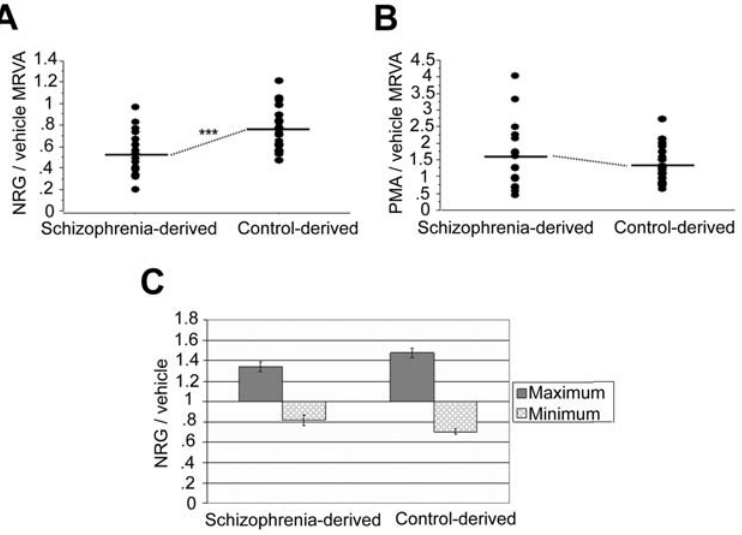
Figure 8. Neuregulin-1-induced, integrin-mediated varying cell adhesion is impaired in cell lines derived from patients with schizophrenia. The NRG/vehicle MRVA was significantly lower in lymphoblasts derived from patients compared with those derived from normal controls (A). PMA/ vehicle MRVA was similar between patient-derived and control-derived cell lines (B) . The relative impairment in patient-derived cells did not seem to be isolated to attachment or detachment, but was indicative of an overall more constricted response with less variation from baseline adhesion in response to NRG1 a (C) . *** represents p , 0.001.